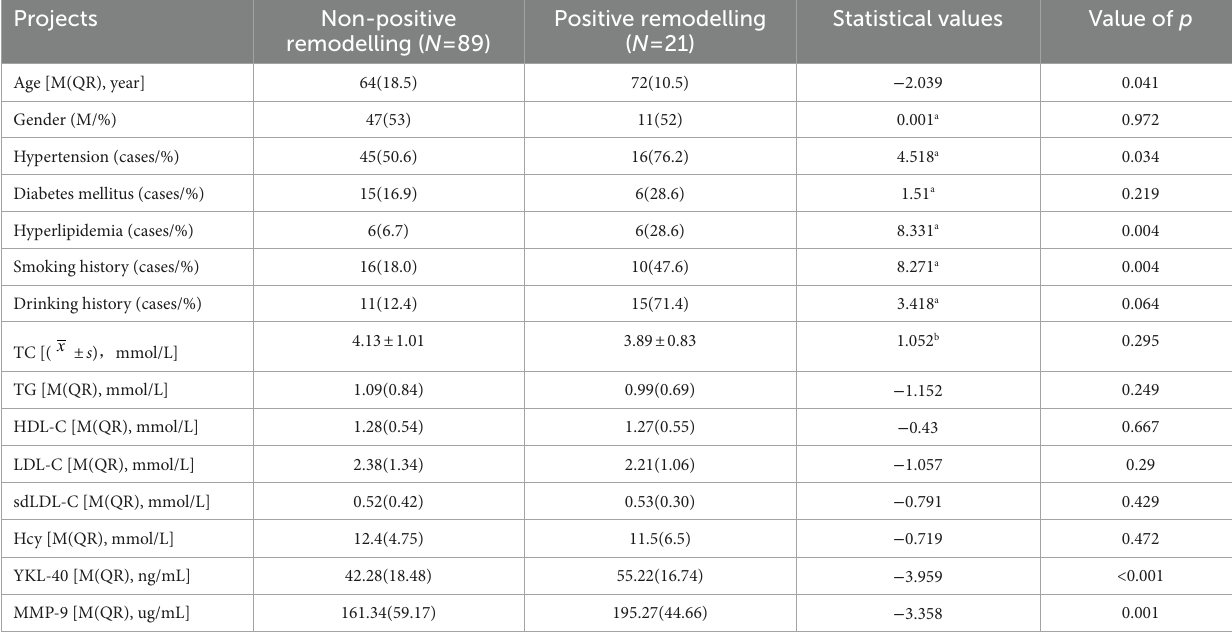
TABLE 1 Comparison of positive and non-positive remodelling.